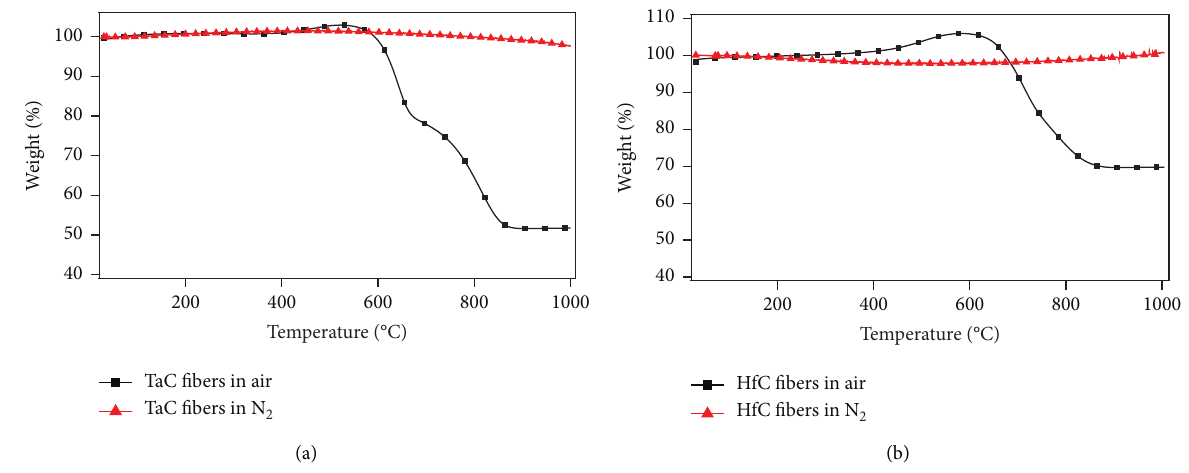
Figure 8: (a) TGA curve of TaC fibers in air and in inert environment (N (N 2